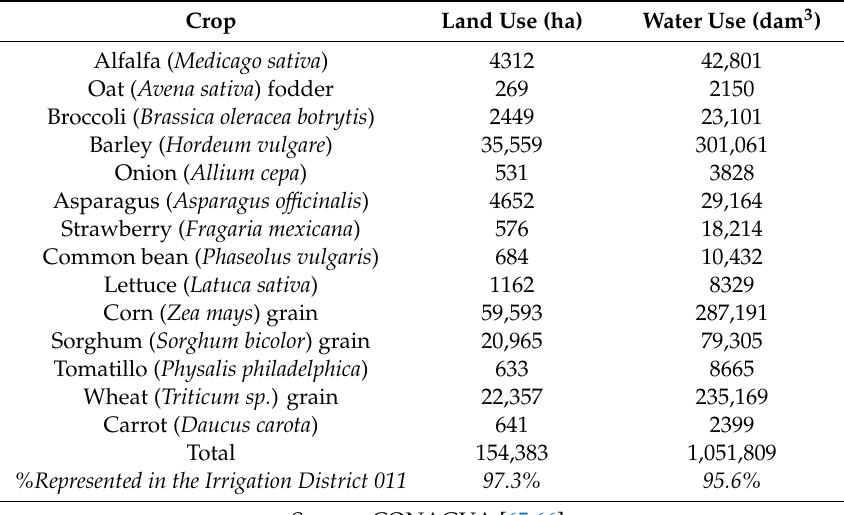
Table 1. Base crop mix for Irrigation District 011 in the 2016–2017 base